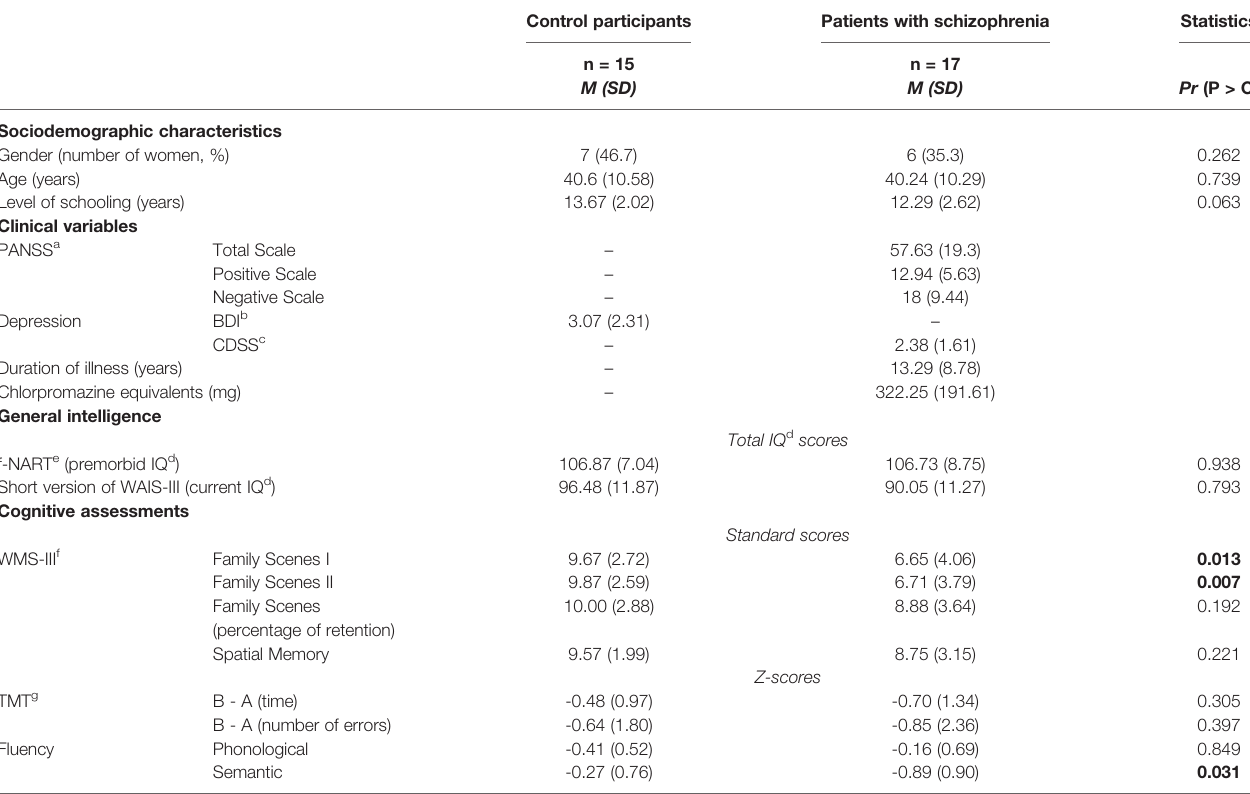
TABLE 1 | Means (M) and standard deviations (SD) of sociodemographic, clinical, and cognitive measures for patients with schizophrenia and